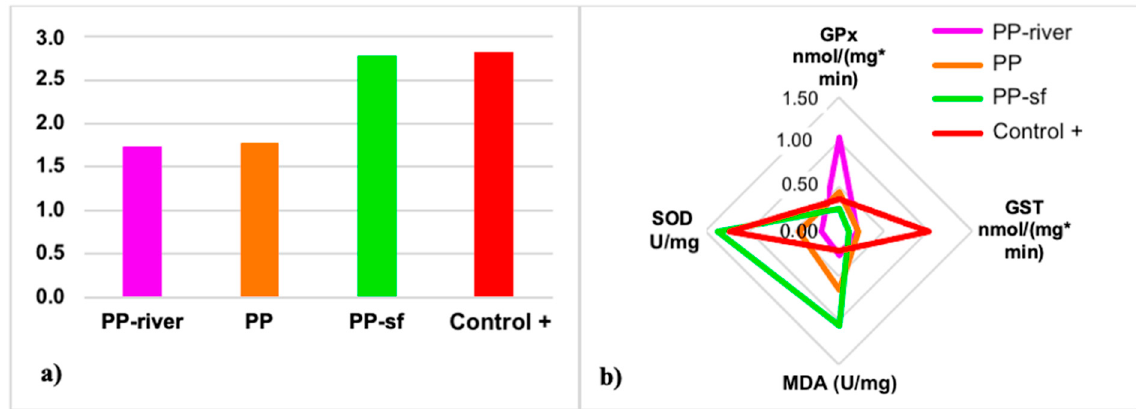
Figure 7. ( a ) IBRv2 for each treatment. ( b ) Star plot based on the reference deviation of each biomarker: SOD, superoxide dismutase; GPx, glutathione peroxidase; MDA, malondialdehyde; GST, glutathione S-transferase. Control − denotes negative control; PP polypropylene unconditioned; PP-sf denotes polypropylene preconditioned in Triton X-100 solution; PP-river polypropylene pre-conditioned in riverine water; Control+ positive control.